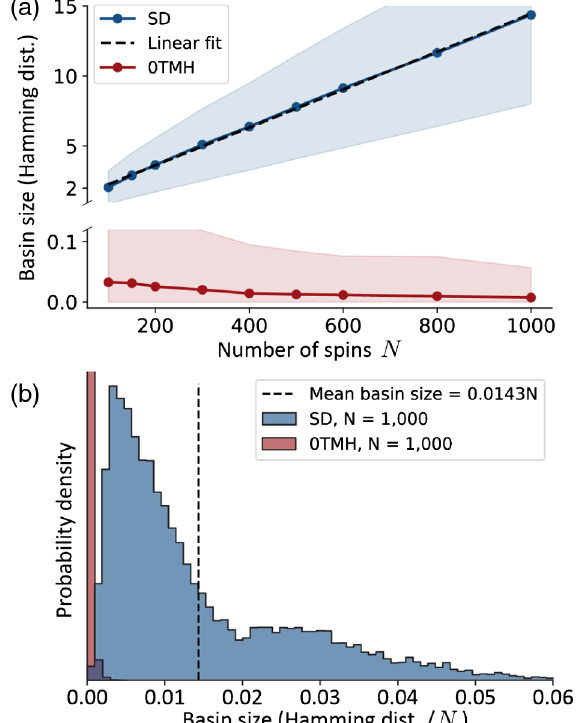
FIG. 11. (a) Average basin size of randomly found local minima for the SK model using 0TMH (red) or SD (blue). The shaded region corresponds to (cid:2) 1 standard deviation in the basin sizes. For each N , the basin size is averaged over 50 realizations of J matrices, with 500 random initial states per J ij ij realization. (b) Histogram of basin sizes using 0TMH (red) and SD (blue) for the N ¼ 1000 data plotted in (a). The mean basin size for SD is marked by the vertical dashed